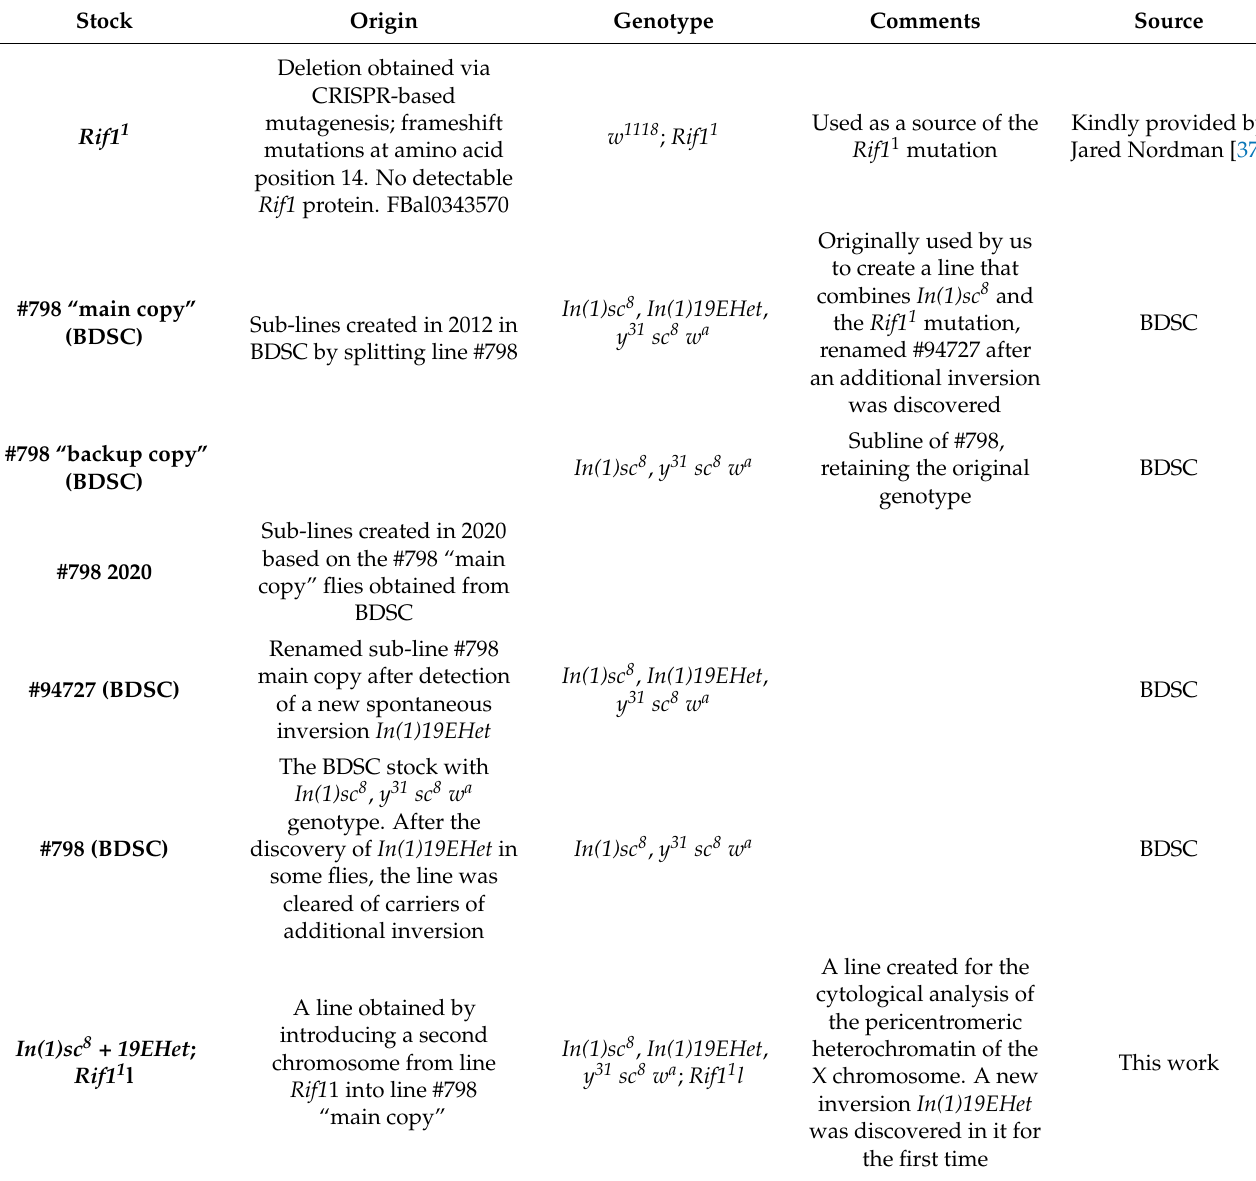
Table 1. Description of the D. melanogaster lines used in this